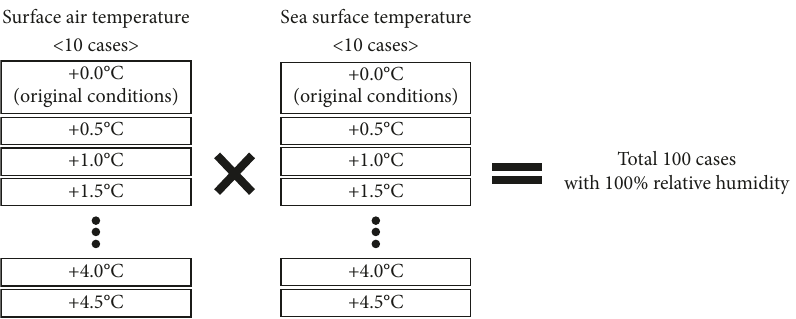
Figure 4: Composition of numerical experiments on SAT and SST incremental combinations.